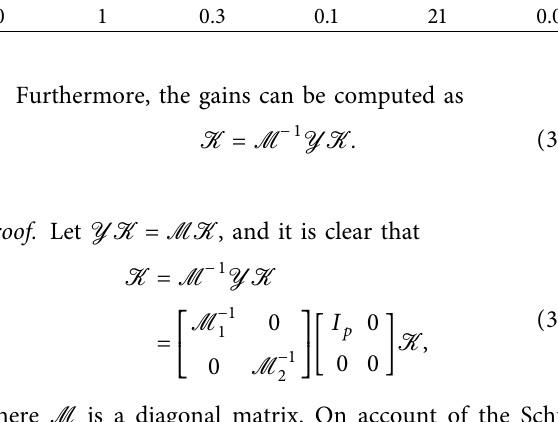
Figure 2: Te control input u ( t ) .